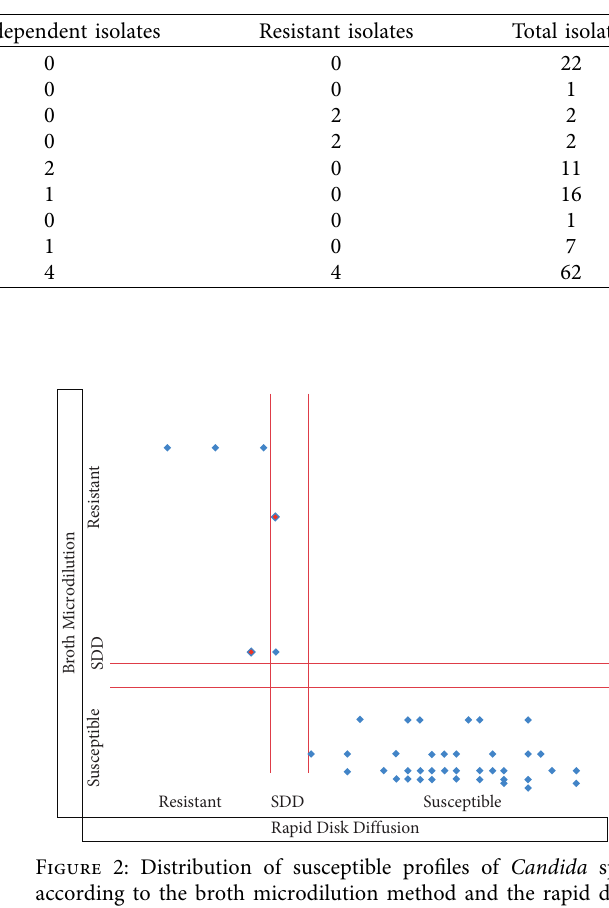
Table 2: Distribution of Candida spp. and their fluconazole susceptibility profiles according to the gold standard (broth microdilution). The minimum inhibitory concentration (MIC) found for Candida spp. ranged from 0.125 to 32.0 μ g/mL, and MIC 50 and MIC 90 were 0.5 and 4.0 μ g/mL, respectively.